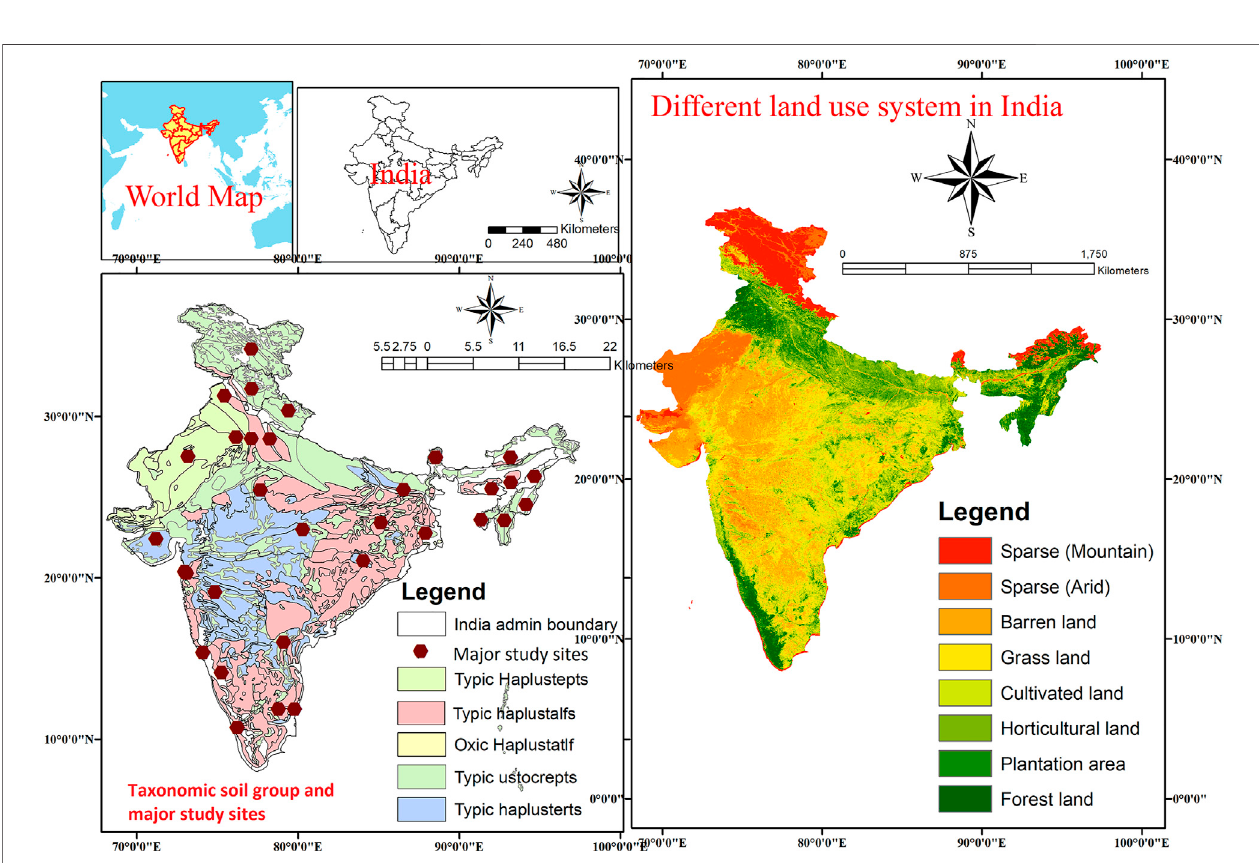
FIGURE 2 | Different land use systems and taxonomic soil group in India showing location map of major study sites.